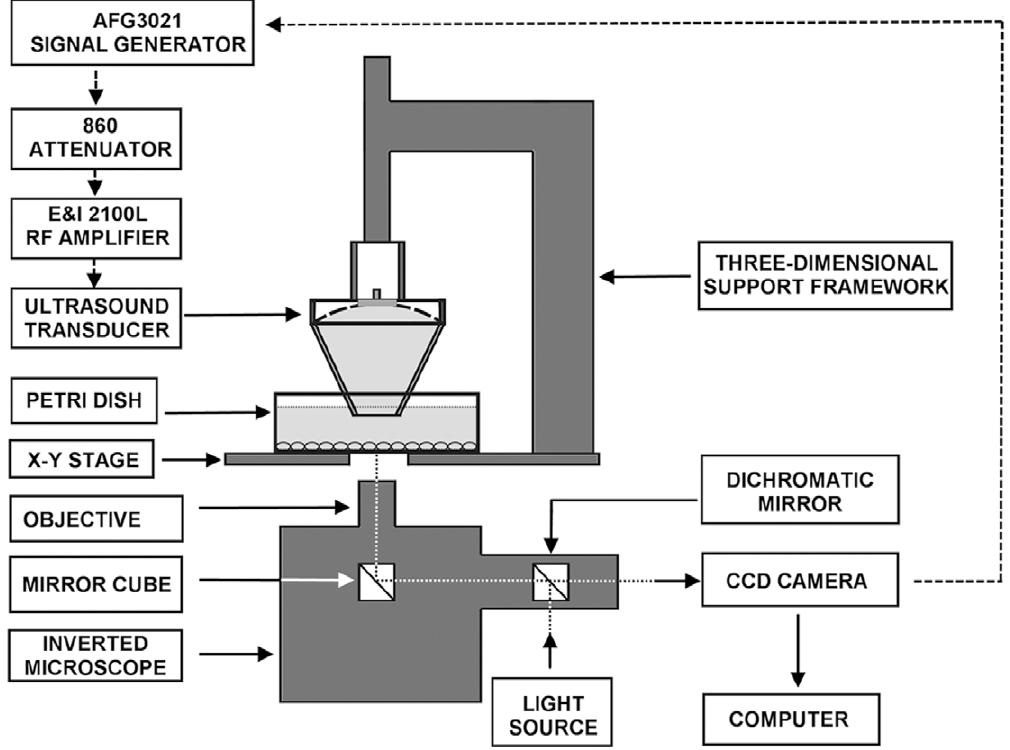
Figure 1. Schematic diagram of experimental setup for spatiotemporal measurements of the effects of acoustic radiation force on MC3T3-E1 cells. The setup includes an inverted microscope and a high intensity focused ultrasound system. Movement of the spherical transducer is controlled by the three-dimensional support framework.